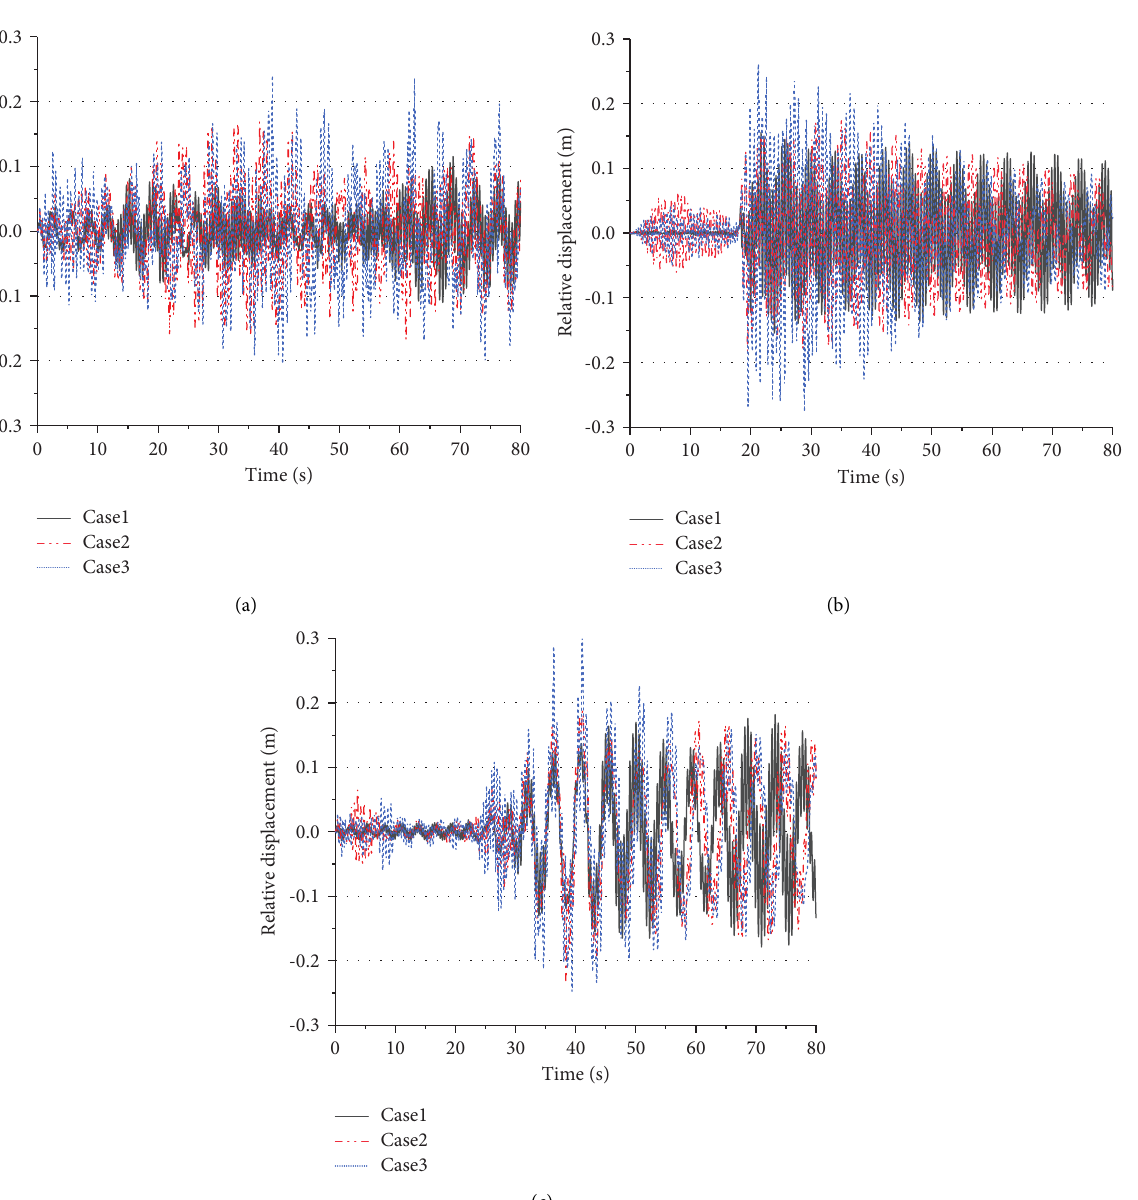
Figure 11: Relative displacement time history of No. 3 pier in the three earthquakes. (a) 2011-03-11. (b) 2012-03-14. (c)